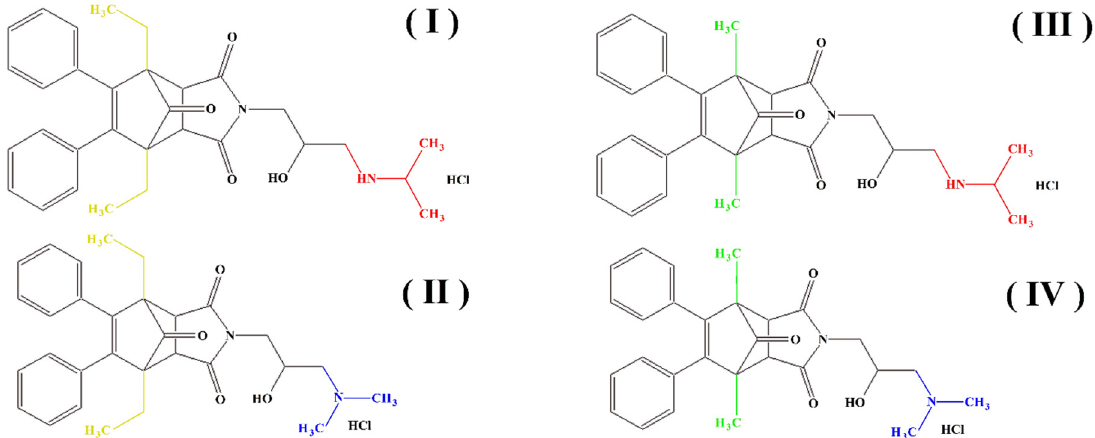
Figure 2. Structures of aminoalkanol derivatives ( I ), ( II ), ( III ) and ( IV ).